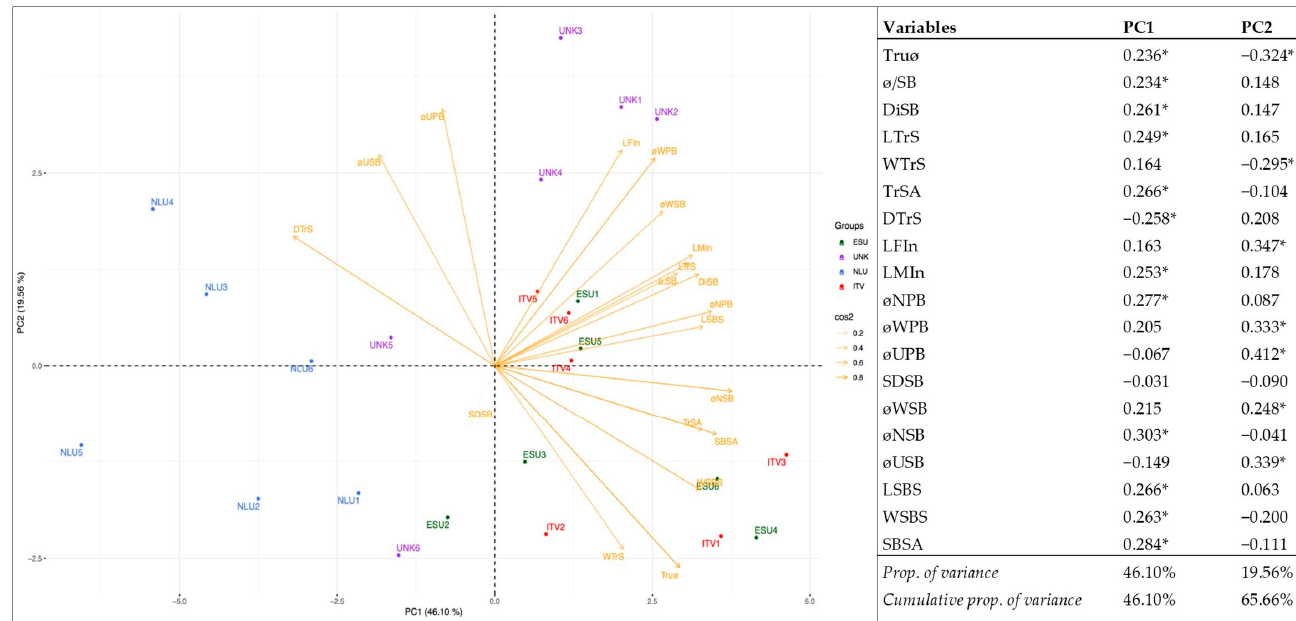
Figure 2. Canopy appearance of the four putative A. araucana populations: ( a ) NLU; ( b ) UNK; ( c ) ESU; ( d ) ITV.